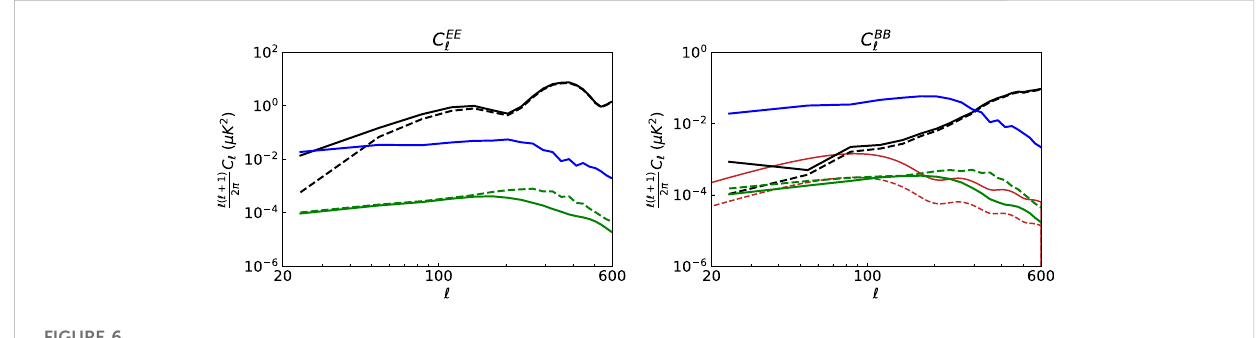
FIGURE 6 Same as in Figure 2, but for the case of the actual point sources with unknown polarization